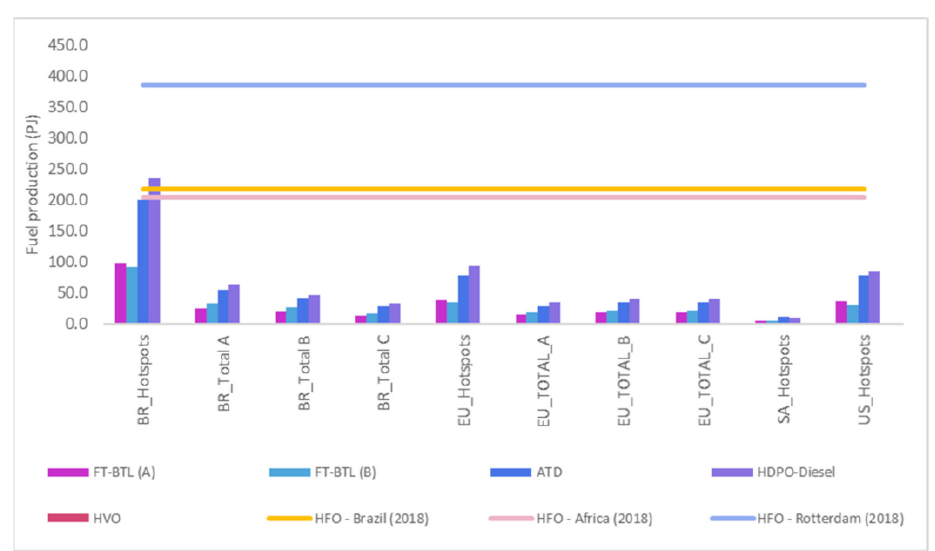
Figure 17. Regional biobunker supply and bunker fuel demand.